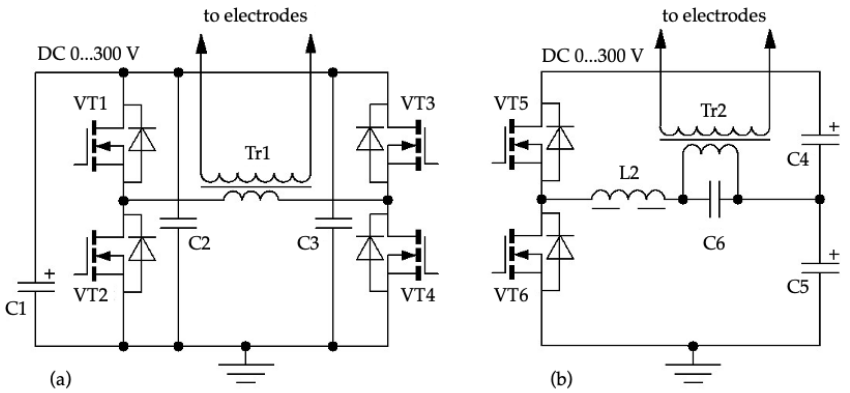
Figure 2. Electrical circuits of short pulse ( a ) and sine ( b ) voltage power supplies. The high efficiency and long lifetime (up to 8000 h) of XeCl* and KrCl* UV radiators driven by DBD have been well described [12,13]. These results are obtained due to high- frequency short-pulse excitation [14] and a special quartz bulb processing technology [15].